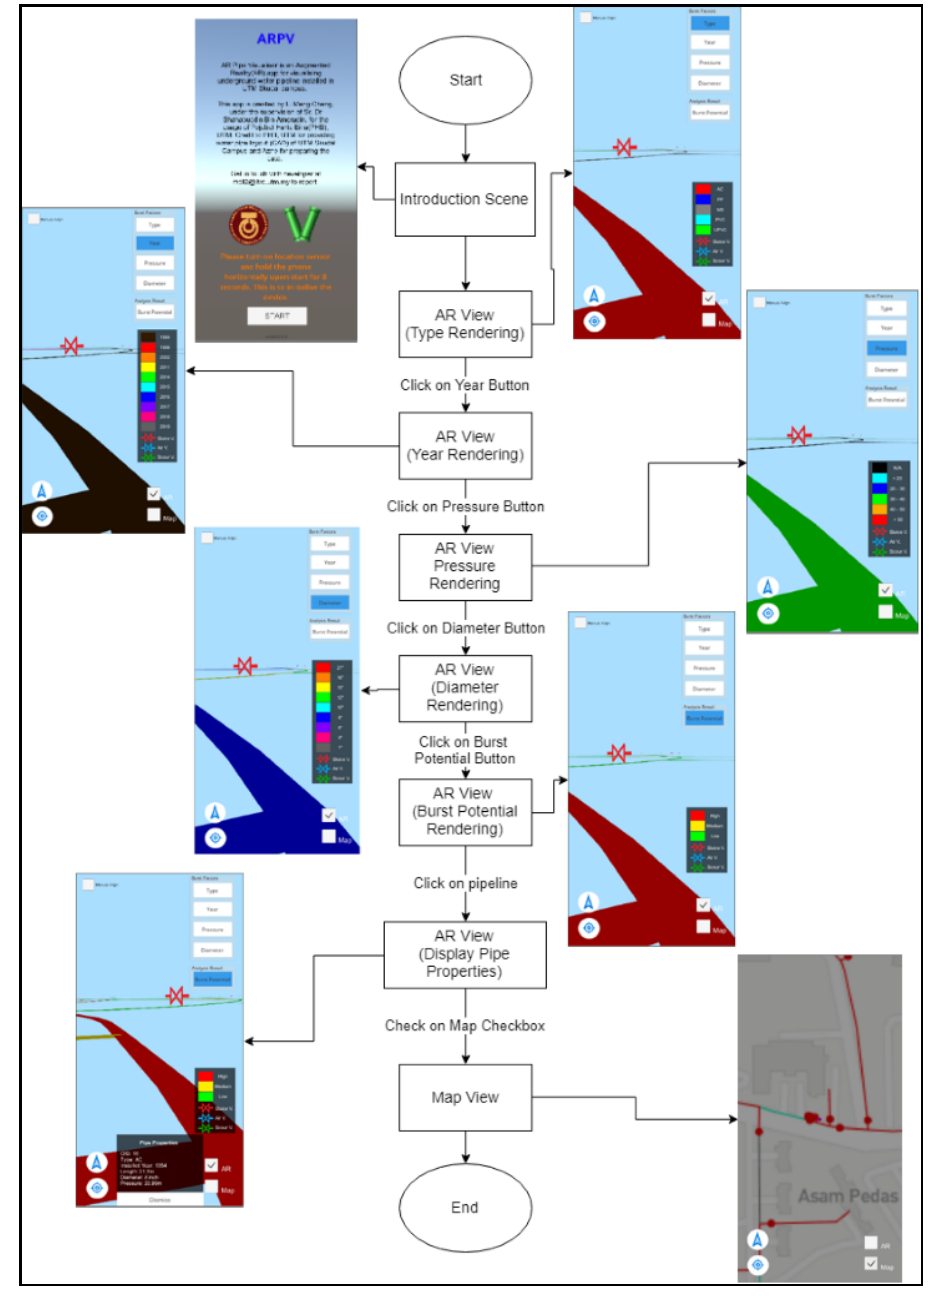
Figure 3. Simplified workflow of ARPV with UI